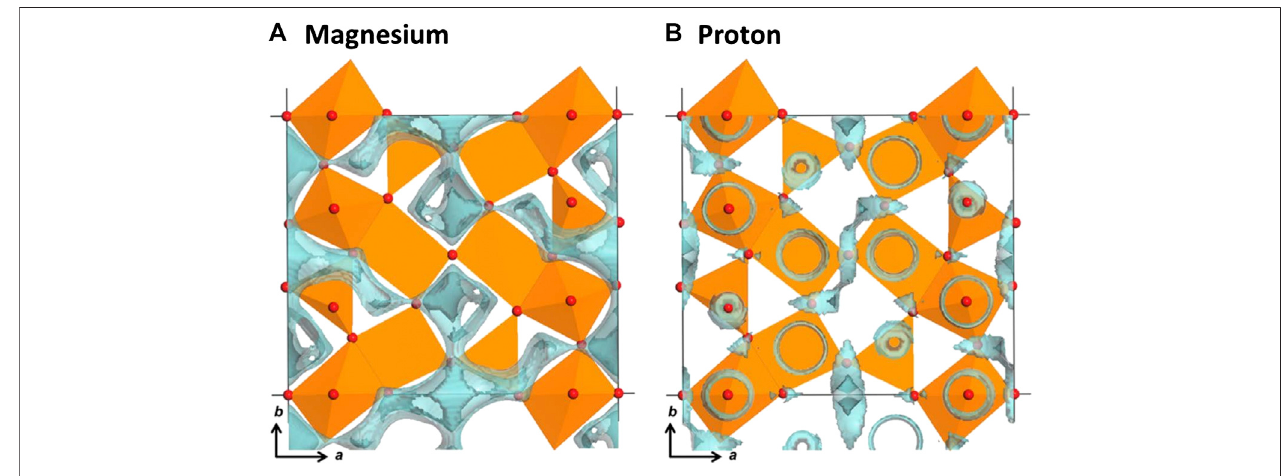
FIGURE 4 | 3D bond valence difference map isosurfaces (sky-blue color) for Mg-inserted V 2 O 5 with the isosurfaces of |0.1| vu for (A) Mg ions and (B) protons. Oxygen atoms are denoted as red balls, and vanadium atoms, not seen in this fi gure, are in the centers of the orange-colored polyhedra. Reprinted (adapted) with permission from Inorg. Chem. 2017, 56, 14, 7668 – 7678. Copyright 2017 American Chemical